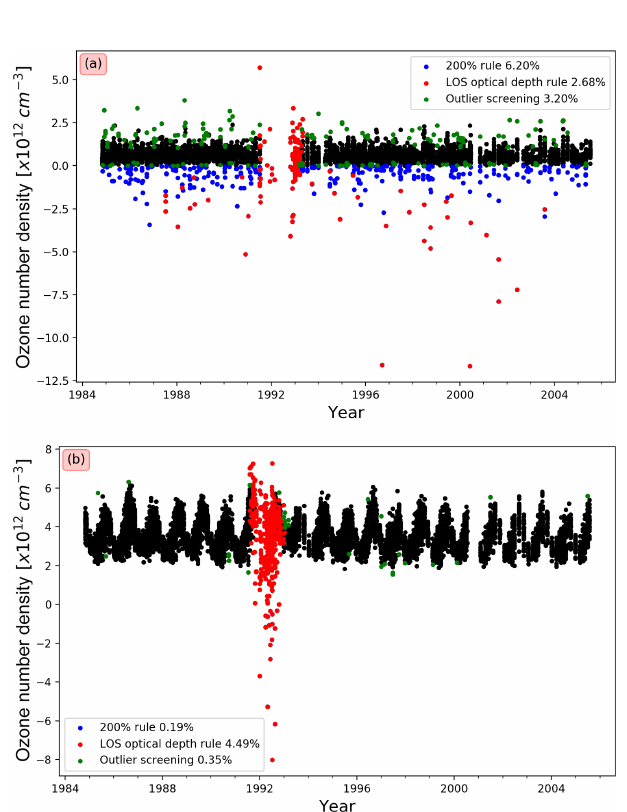
Figure 13. Ozone number density at 17km between 15 and 25 ◦ N (a) and at 20.5km between 25 and 35 ◦ S. The black dots represent the full SAGE II ozone data sets at the given altitude and latitude band, while the coloured dots represent the ozone values that would be removed by applying the new rules (as indicated in the legend). Note that all rules were applied individually to all data